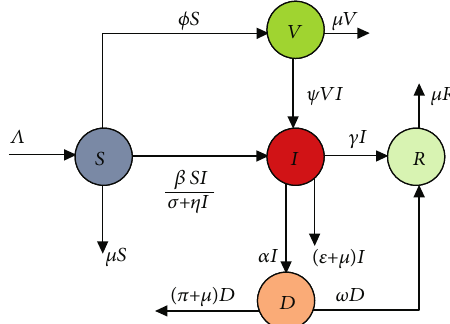
Figure 1: The schematic fl owchart of COVID-19